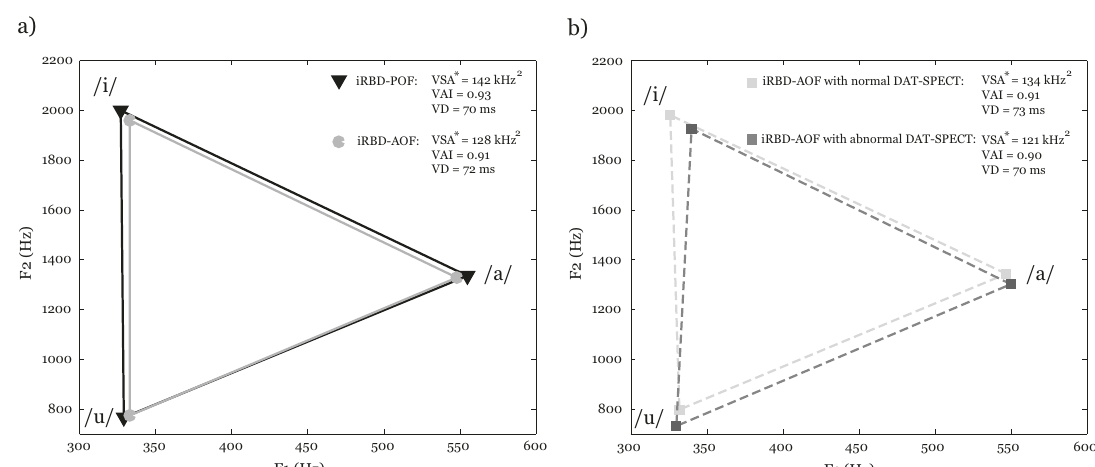
Fig. 2 Mean F1 and F2 values and vowel space area for a) iRBD-POF compared iRBD-AOF subgroups and b) iRBD-AOF with normal DAT- SPECT compared to iRBD-AOF with abnormal DAT-SPECT. VSA vowel space area, VAI vowel articulation index, VD vowel duration, iRBD-POF isolated rapid eye movement sleep behaviour disorder patients with preserved olfactory function, iRBD-AOF isolated rapid eye movement sleep behaviour disorder patients with abnormal olfactory function, DAT-SPECT dopamine transporter single-photon emission computed tomography; “ Asterisks ” indicate signi fi cant differences: * p < 0.05.